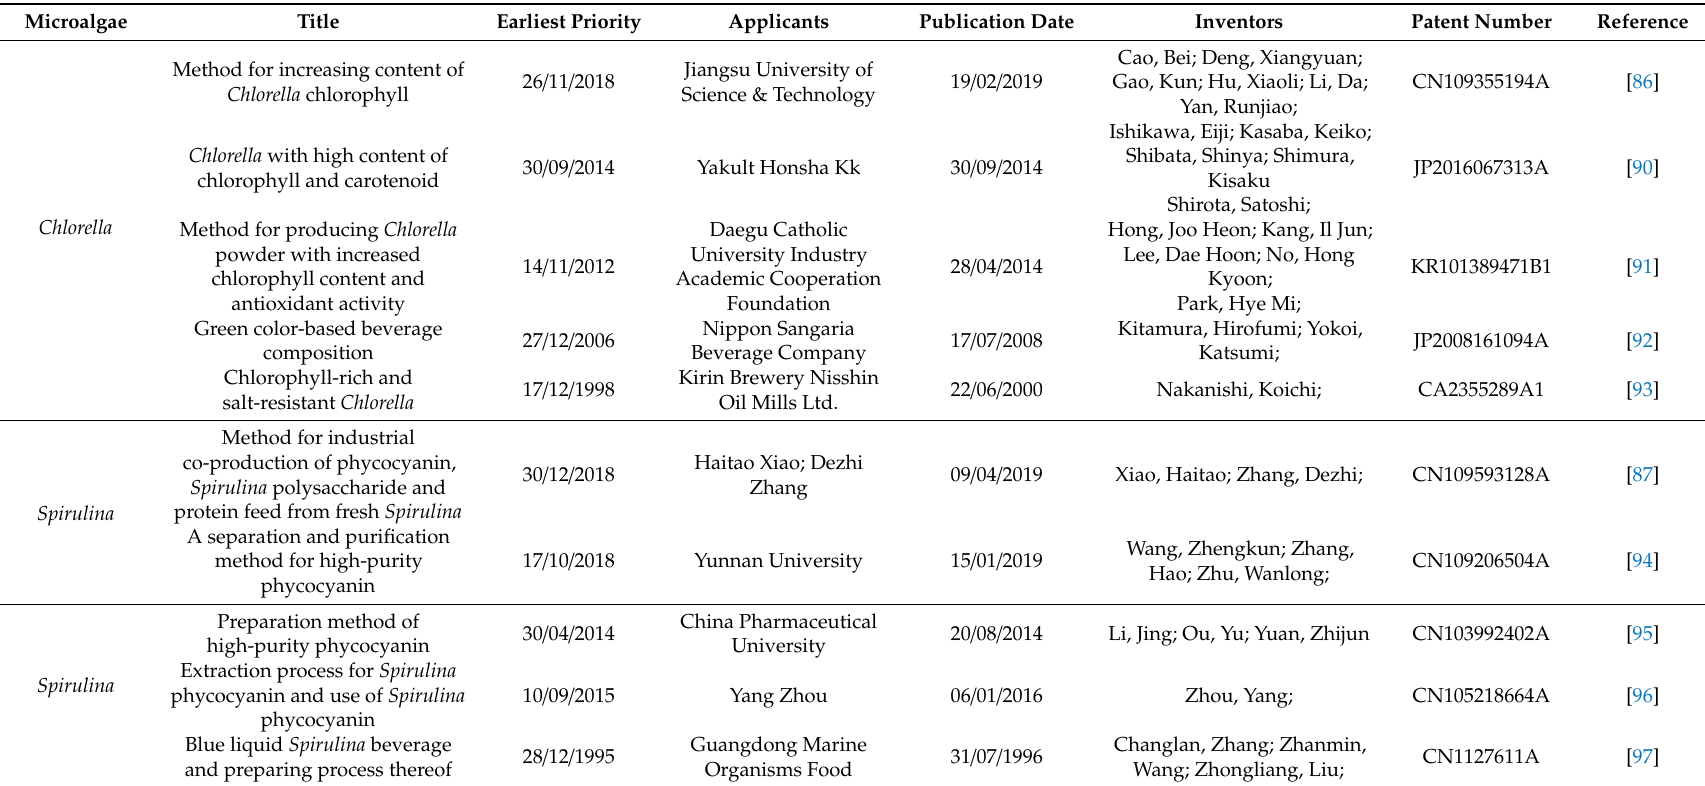
Table 3. Details of patents in the field of pigments from